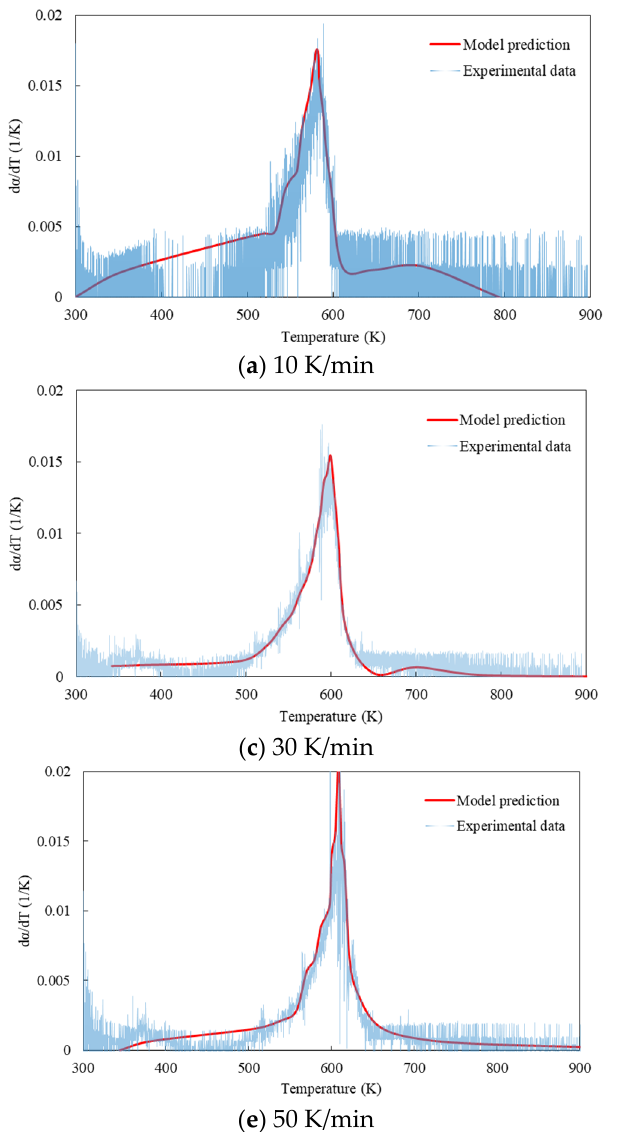
Figure 6. Comparison of the predicted conversion rate using the evaluated kinetics by the new model and the experimental data of Artemisia stem pyrolysis under different heating rates ( a ) 10 K/min, ( b ) 20 K/min, ( c ) 30 K/min, ( d ) 40 K/min and ( e ) 50 K/min.